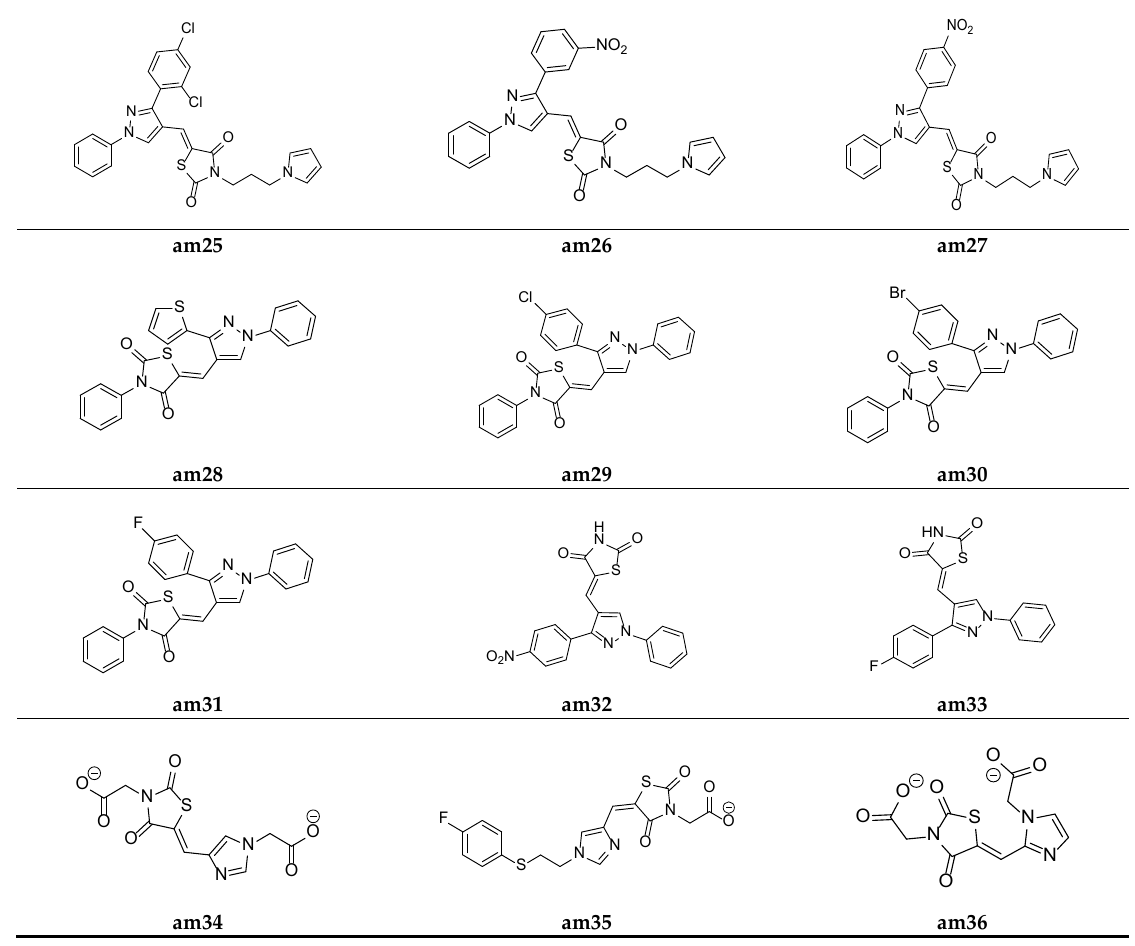
Figure 11. Molecular structures of the compounds (am25 – am36). Prakash et al. synthesized another series of thiazolidine-2,4-diones molecules and screened them for their in vitro antimicrobial potential against various bacterial and fungal strains. Among the synthesized derivatives, compounds, am32 and am33 were found to be equipotent antibacterial and antifungal agents in comparison to the standard drugs ciprofloxacin and fluconazole as the antibacterial and antifungal agents, respectively (Table 14, Figure 11) [54]. Table 14. Antimicrobial activity of the compounds (am32 – am33).